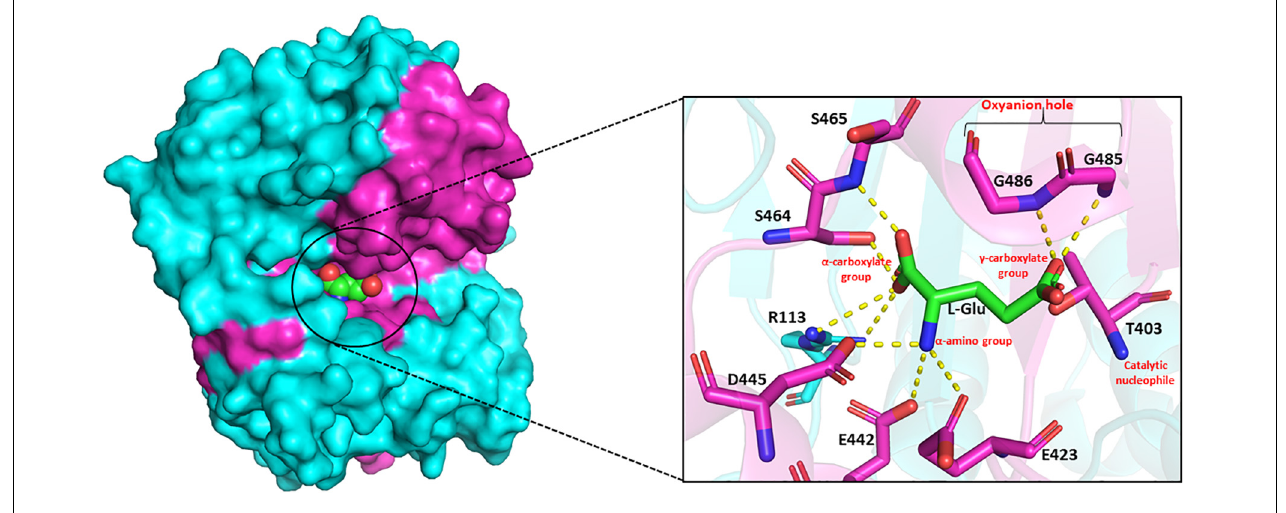
FIGURE 5 | Side view of surface drawing of Bacillus subtilis gamma-glutamyl transpeptidase (BsGGT) (PDB ID: 3A75) showing the binding pocket groove and interaction of L-glutamic acid (L-Glu) with active site residues of BsGGT. Cyan color highlights large subunit, pink color highlights small subunit, and L-Glu is represented as a sphere in the surface drawing. Hydrogen bonding is represented as yellow dashed lines. The structures are prepared using PyMOL2 software.